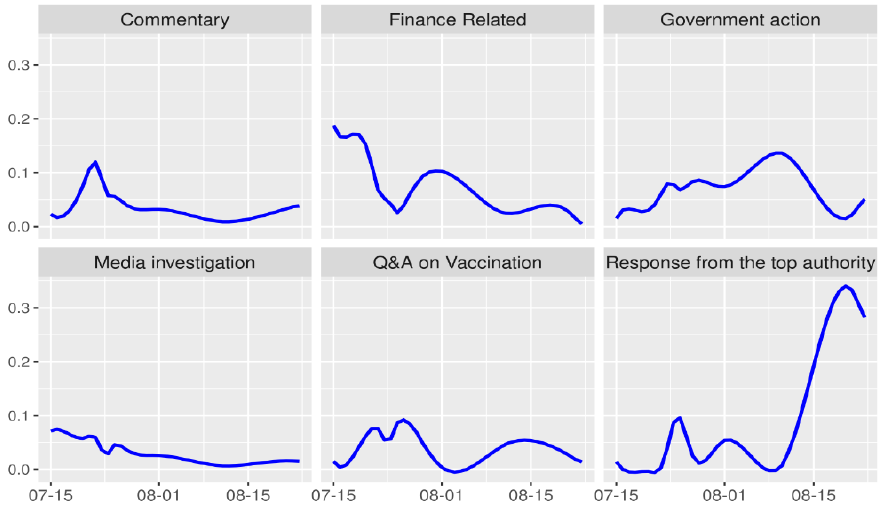
Figure 4. Time trends of the topic